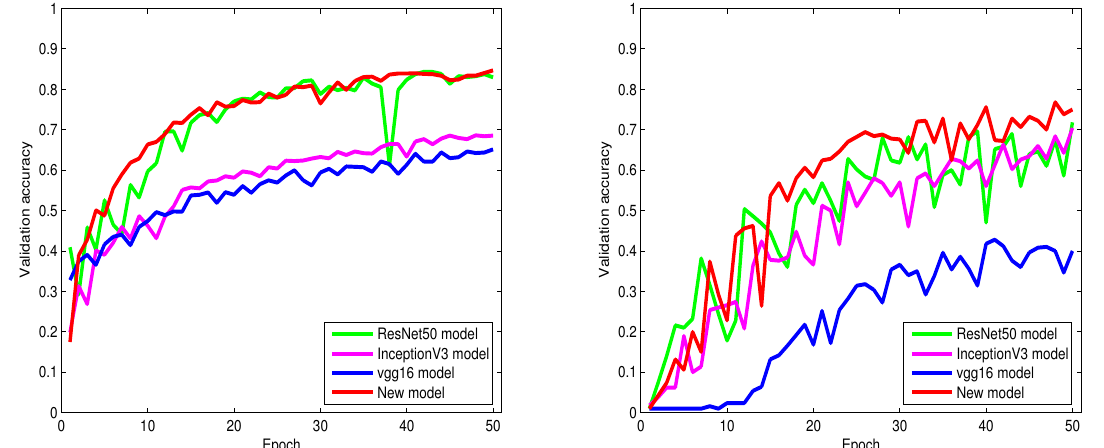
Figure 6. From left to right: the validation accuracy of the trained models on the noisy (Gaussian noise) CIFAR-10 dataset and noisy (Gaussian noise) 100 Sports image classification